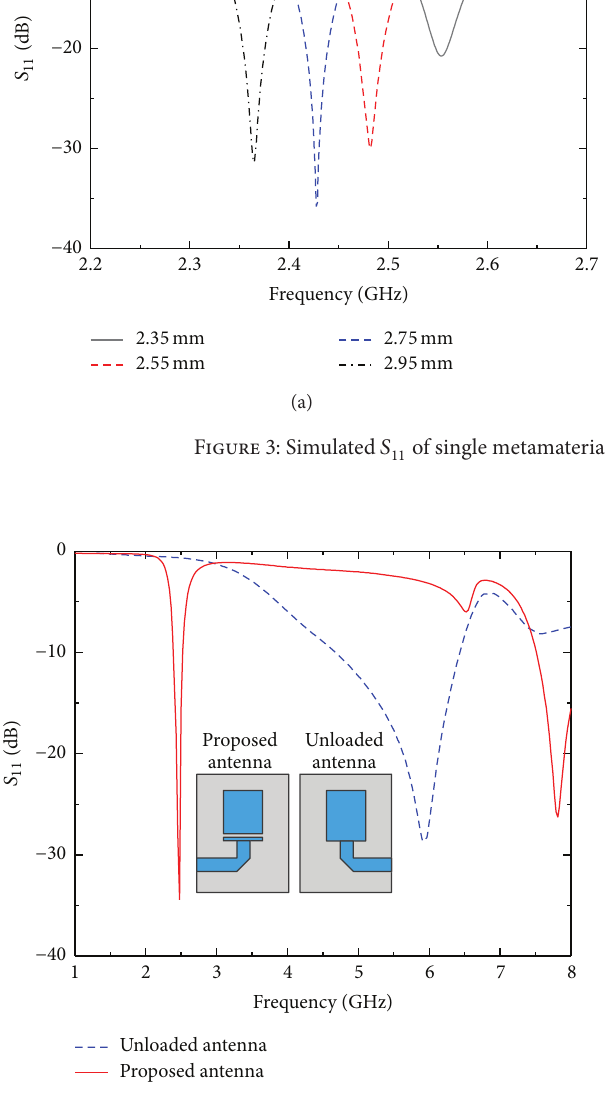
Figure 4: Simulated 𝑆 11 of unloaded and proposed antennas.